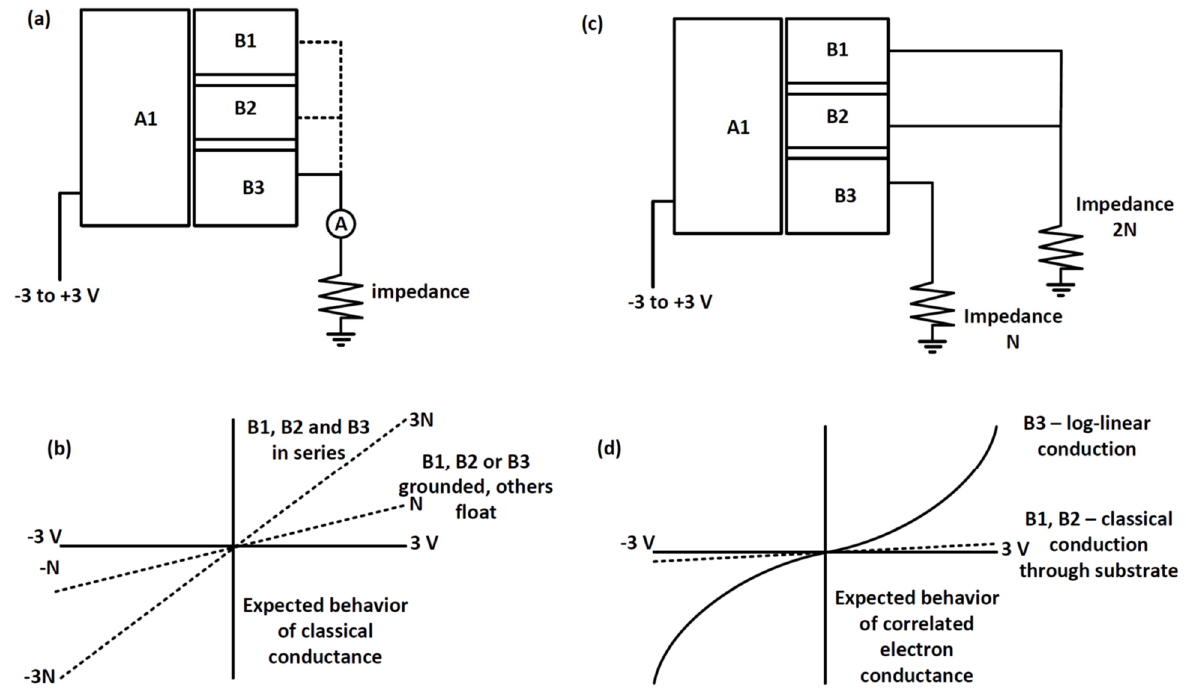
Figure 1. ( a ) Conceptual circuit design showing electrodes connected in parallel to ground through the same impedance (Configuration 1), ( b ) classical I/V current behavior, ( c ) conceptual circuit design showing electrodes connected in parallel to ground through different impedances (Configuration 4), and ( d ) log-linear approximation of coherent electron transport I/V behavior through quantum dot